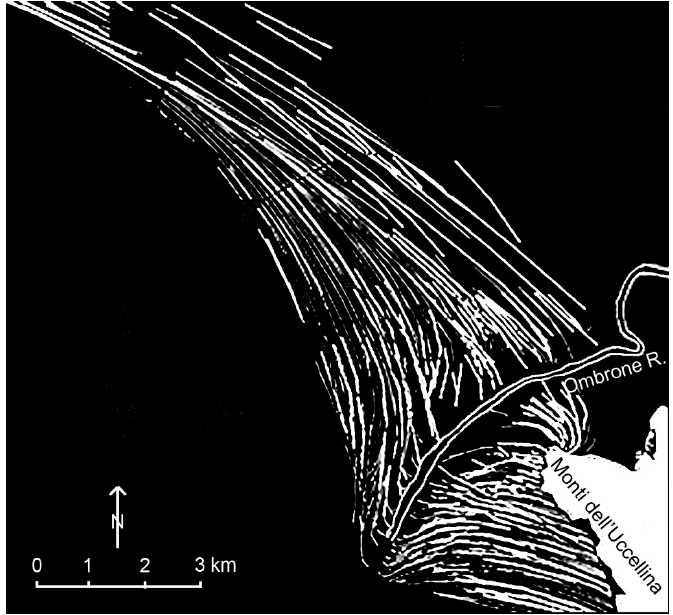
Figure 2. Ombrone River delta, beach ridges pattern mapped through the combination of di ff erent data sets and elaboration